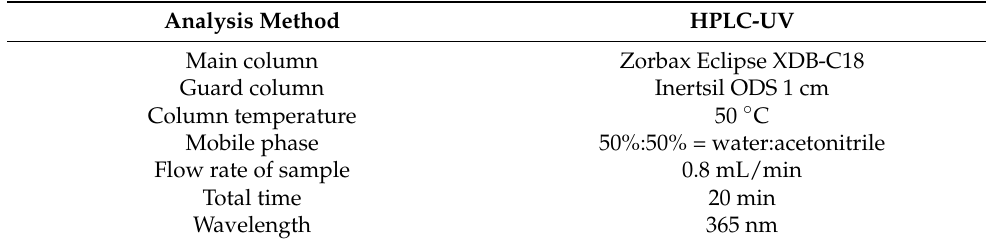
Table 2. Specifications of HPLC for Aldehyde and Ketone Test.